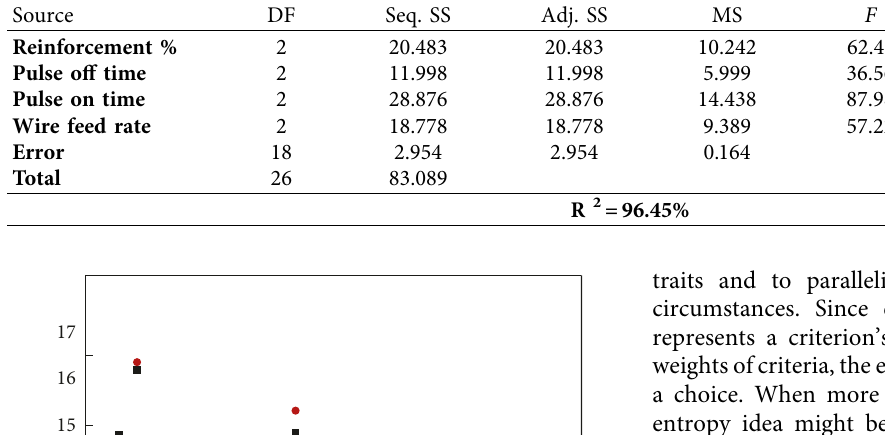
Table 8: ANOVA for MRR.